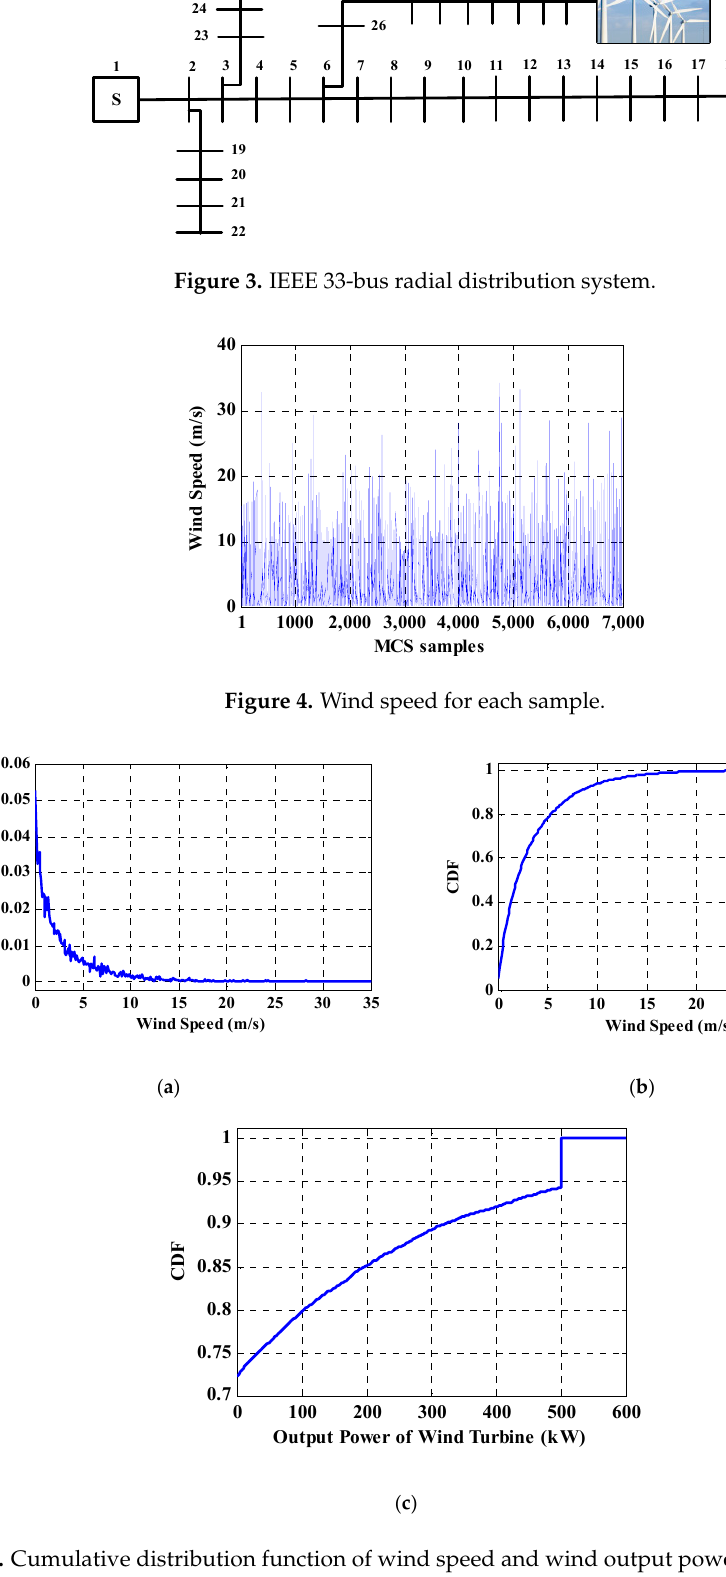
Figure 5. Cumulative distribution function of wind speed and wind output power. ( a ) PDF of wind speed samples, ( b ) PDF of wind speed samples, ( c ) CDF of turbine output power.